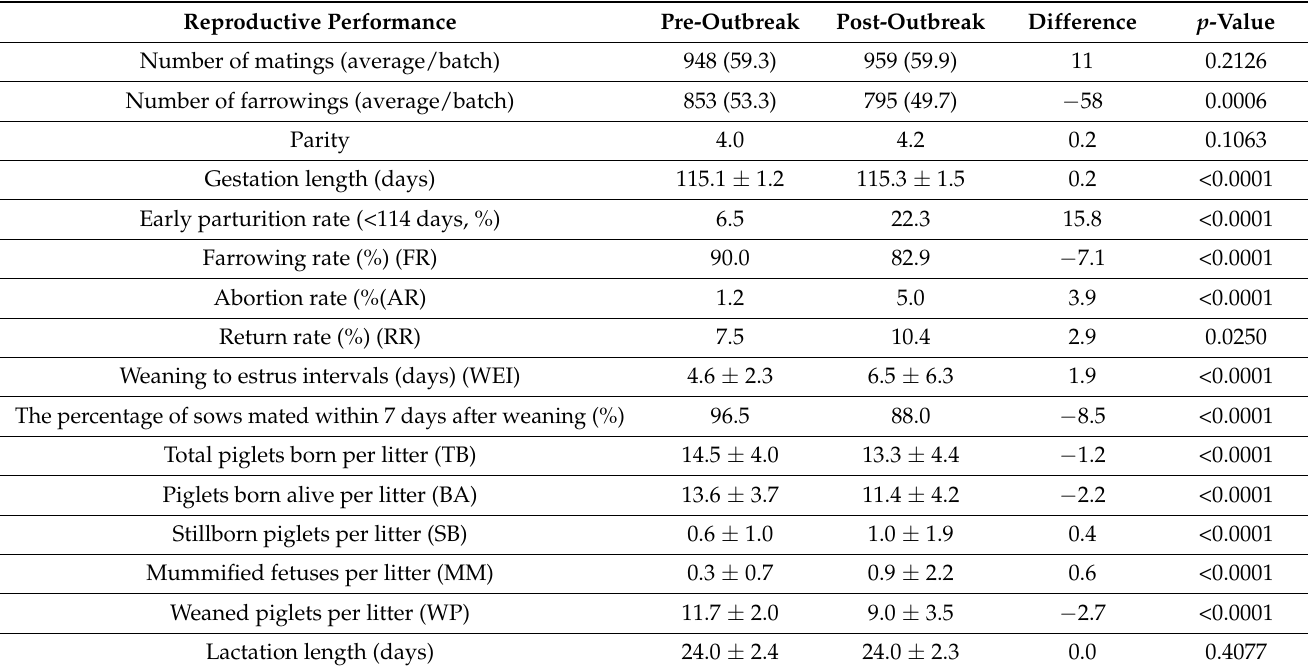
Table 1. Comparison of the reproductive performance of gilts and sows before and after a porcine reproductive and respiratory syndrome (PRRS) outbreak on a farrow-to-nursery farm.